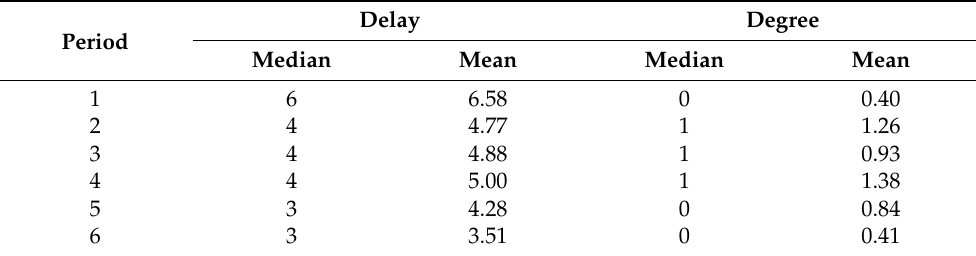
Figure 5. Cluster heatmaps for delay and degree where cases with delay >8 or degree >50 are truncated (23.7%, 9.2%, 10.5%, 10.4%, 6.5%, and 2.9% of total cases of each period). The density ranges from 0–0.14 for P1–5 and 0–0.25 for P6. Table 3. Statistics of diagnostic delays and infection degrees. Their medians and means appear to be higher than what the heatmaps of Figure 5 suggest due to the truncated cases with delay >8 or degree